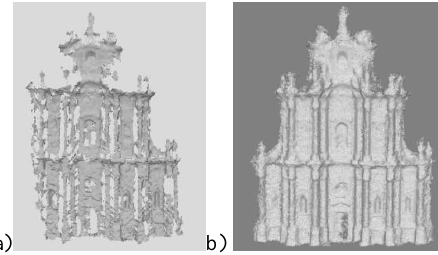
clouds shown above is described in section 5.